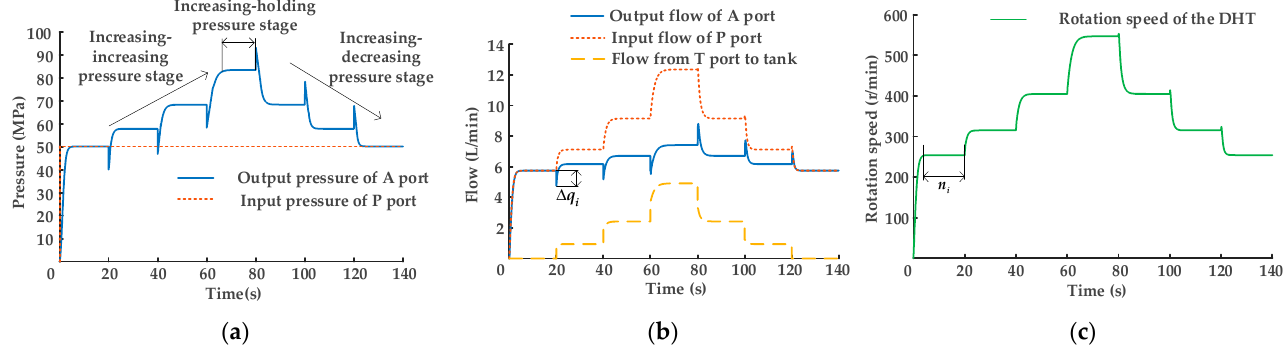
Figure 6. Regulation characteristic curves of DHT in increasing pressure stage: ( a ) pressure regulation; ( b ) flow regulation; ( c ) gear–pump/motor unit rotational speed characteristic curves.